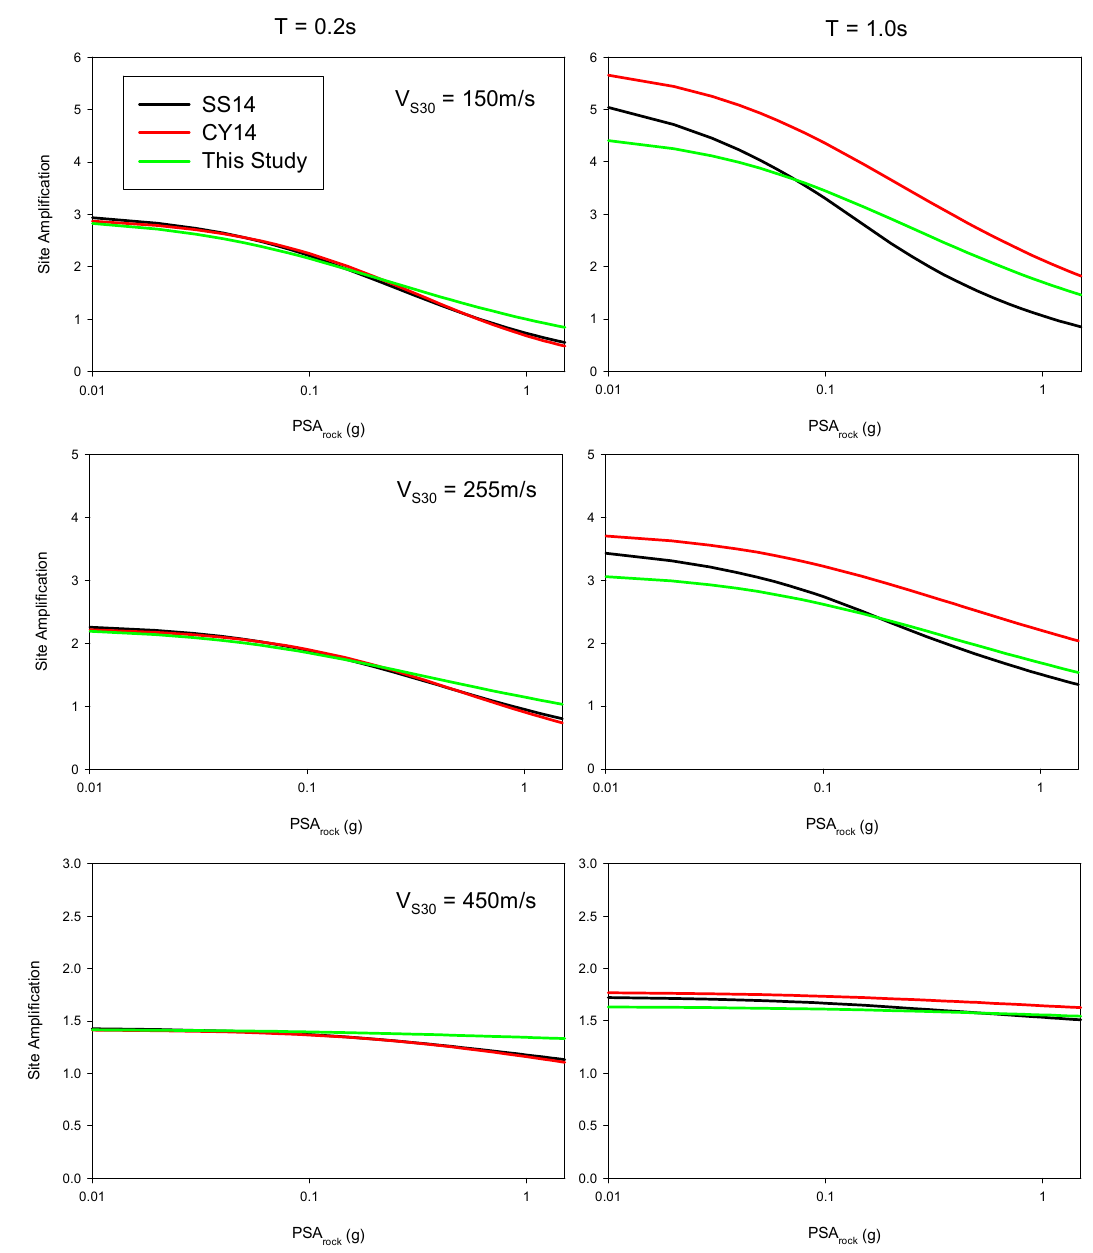
Figure 6. The comparison of the site models for very soft soil ( V S 30 = 150 m/s), soft soil ( V S 30 = 255 m/s), and stiff soil ( V S 30 = 450 m/s) at 0.2 s and 1.0 s. Deep soil effect is not included in the plots.